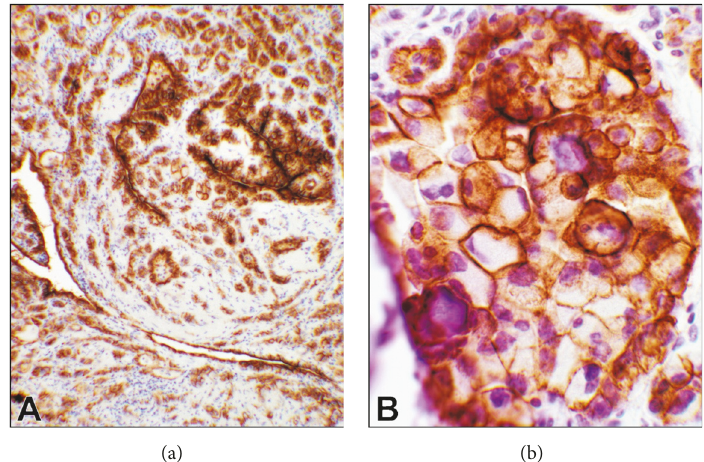
Figure 4: Photomicrographs of D2-40 immunohistochemical (IHC) stain . D2-40IHC is a cell membrane stain and is a specific marker for mesothelial tumors as well as lymphoid endothelial cells and their neoplasms [8, 9]. ((a), 10x objective) The tumor cells as well as the vascular structures show strong reaction. ((b), 40x objective) A cluster of the foamy cells with the intense cell membrane